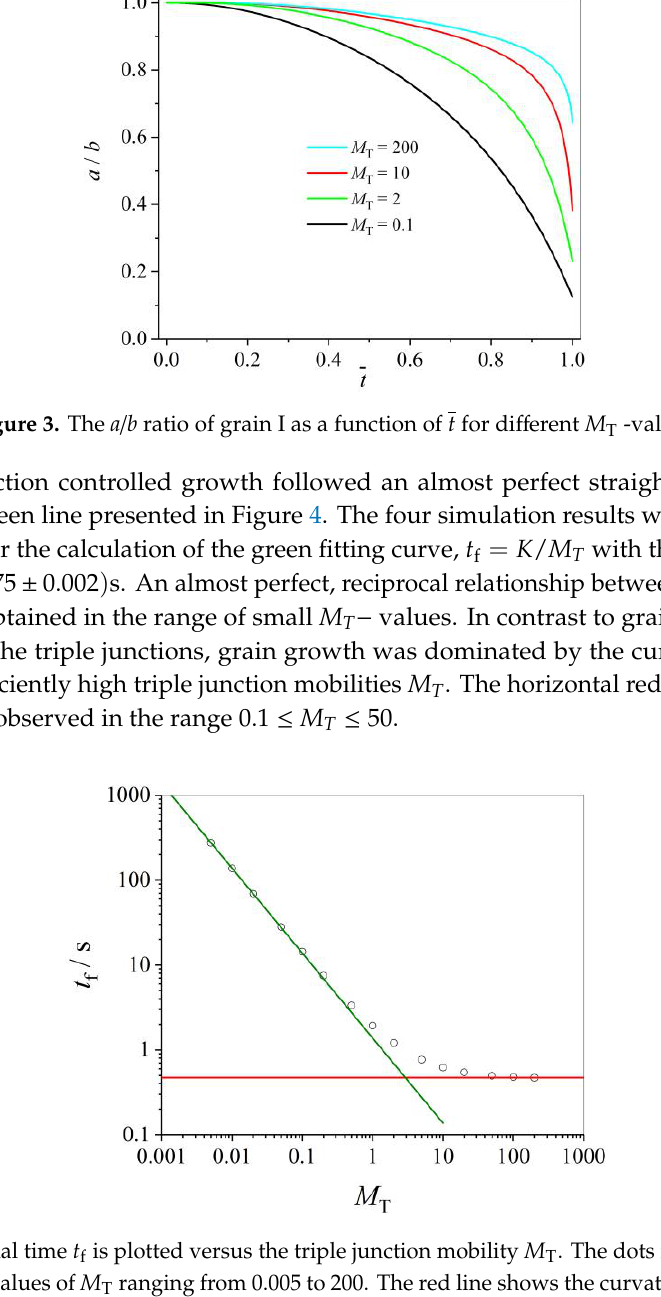
M − values in Figure 3. T